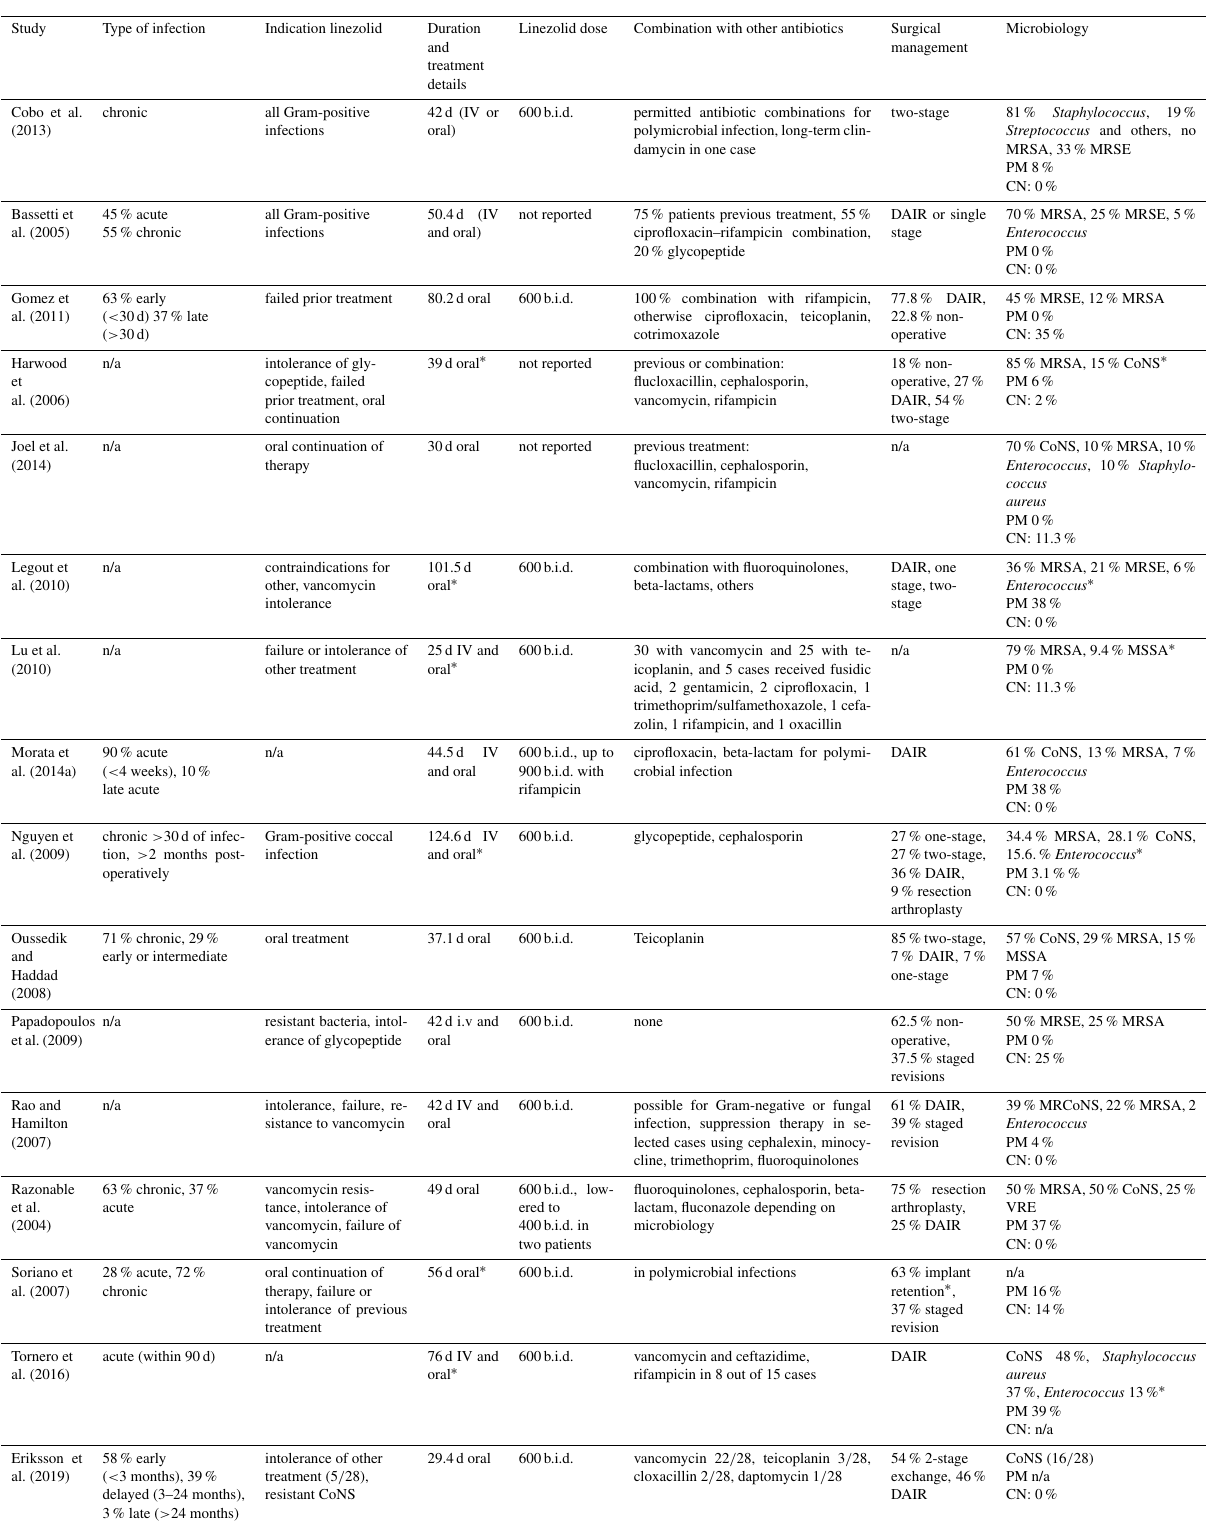
Table 2. Systemic and local treatment details, microbiological